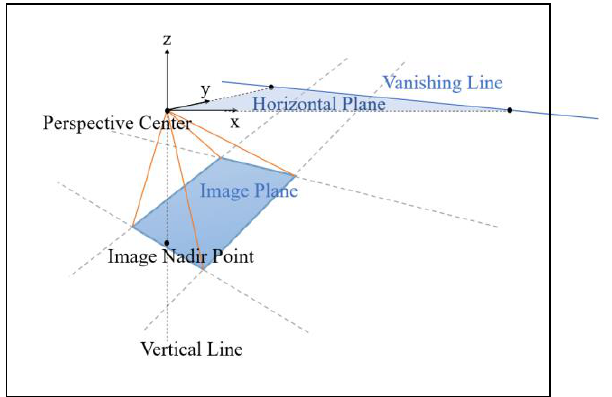
Figure 4. The vanishing line and the image-space nadir